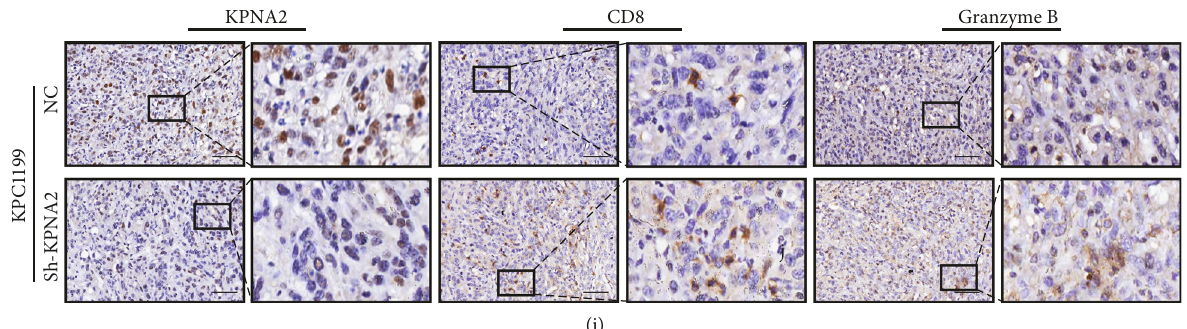
Figure 3: Increased KPNA2 promoted PD-L1 expression and thereby contributed to tumor immune evasion. (a) Gene-immune analysis of KPNA2 in PDAC conducted on Sanger box. (b) The correlation between expression levels of KPNA2 and PD-L1 in PDAC. (c) Relative mRNA expression level of PD-L1 target genes in MIA PaCa-2 and PANC-1 cells with sh-KPNA2 or control vector. (d, e) Protein level of PD-L1 on the surface of MIA PaCa-2 and PANC-1 cells with sh-KPNA2 or control vector. (f, g) Relative mRNA expression level and protein level of PD-L1 in KPC1199-luc cells with sh-KPNA2 or control vector. (h) Protein level of PD-L1 on the surface of tumor cells derived from orthotopic PDAC model mice orthotopically transplanted KPC1199-luc cells with sh-KPNA2 or control vector. (i) CD8 in fi ltration and granzyme B expression in mouse tumor tissue detected by IHC (scale bar: 100 μ